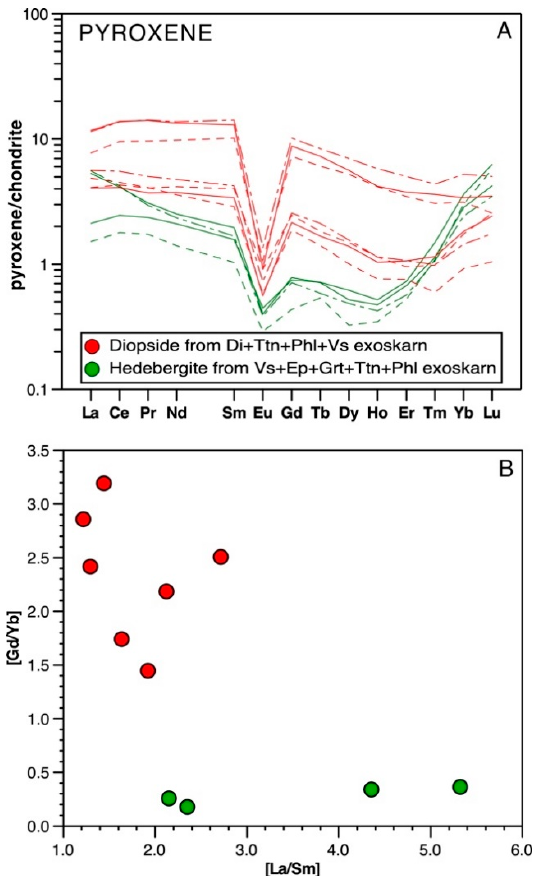
Figure 10. ( A ) Chondrite ‐ normalized REE patterns for metasomatic clinopyroxene. Despite the low value of REE for both groups, hedenbergite from Vesuvianite ‐ rich exoskarn shows different fractionations of both LREE and HREE, as evidenced by the ( B ) Gd/Yb vs La/Sm diagram. Chondrite normalization values are taken from [25].